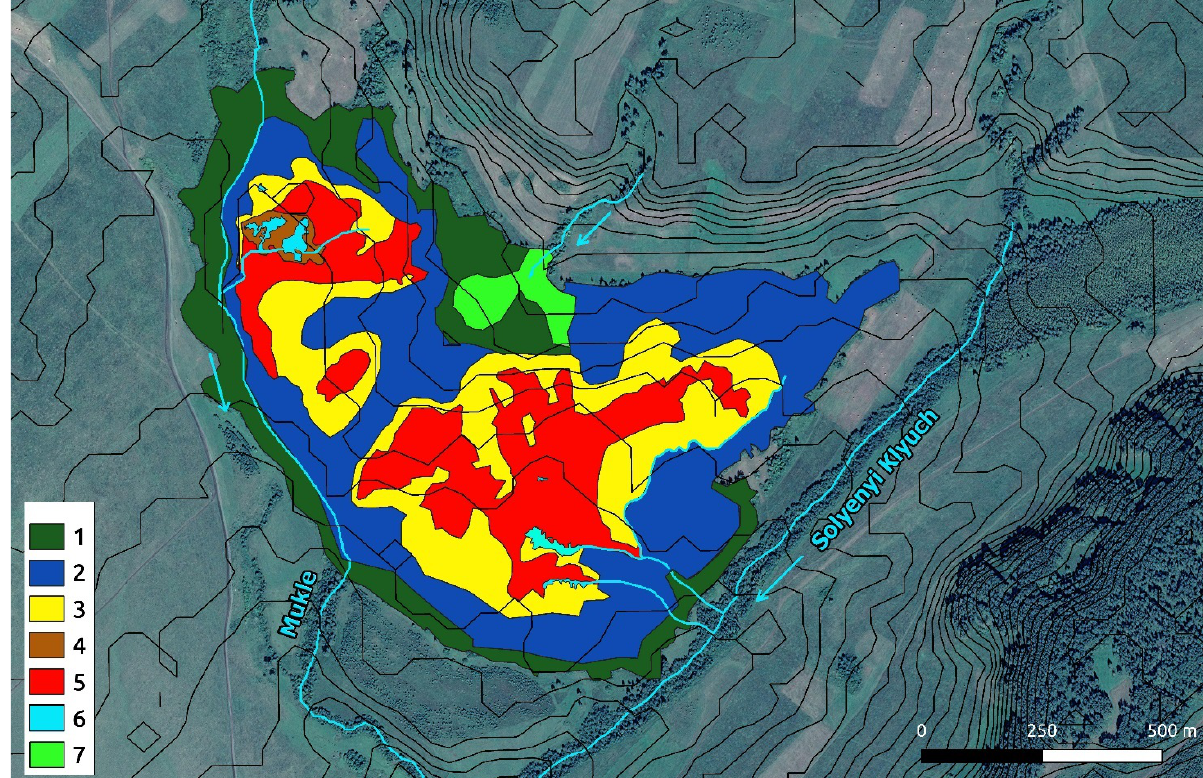
Figure 1. Plan view of the Natural Monument “Arkaulovskoye Mire” (Republic of Bashkortostan, Russia) showing the spatial structure of the mire massif. The mire microlandscape types, identified by their predominant plant community types (as described in the text) are as follows: 1 = periodically flooded grey alder - bird cherry forest; 2 = sedge - reed birch and birch - alder forested mire; 3 = sparse pine and birch forested mire; 4 = moss - shrub dwarf pine forested mire; 5 = Schoenus ferrugineus - small sedges - brown mosses open mire; 6 = large pools and streams; 7 = vegetation complexes of birch tree stands and hayfields on mineral soils. The contour interval is 3